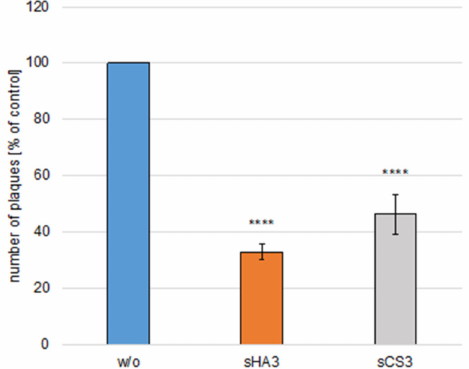
Figure 7. Effects of GAGs on virus inactivation. High-titer BCoV (MOI 0.005) was incubated either with sHA3 or sCS3 or with medium for 1 h at 37 ◦ C. The mixture was diluted 1000-fold. PT cells were infected with diluted untreated virus ( w / o ) or pretreated virions (sHA3, sCS3) and subjected to plaque reduction assays. Error bars on the histogram are SD from three independent experiments.